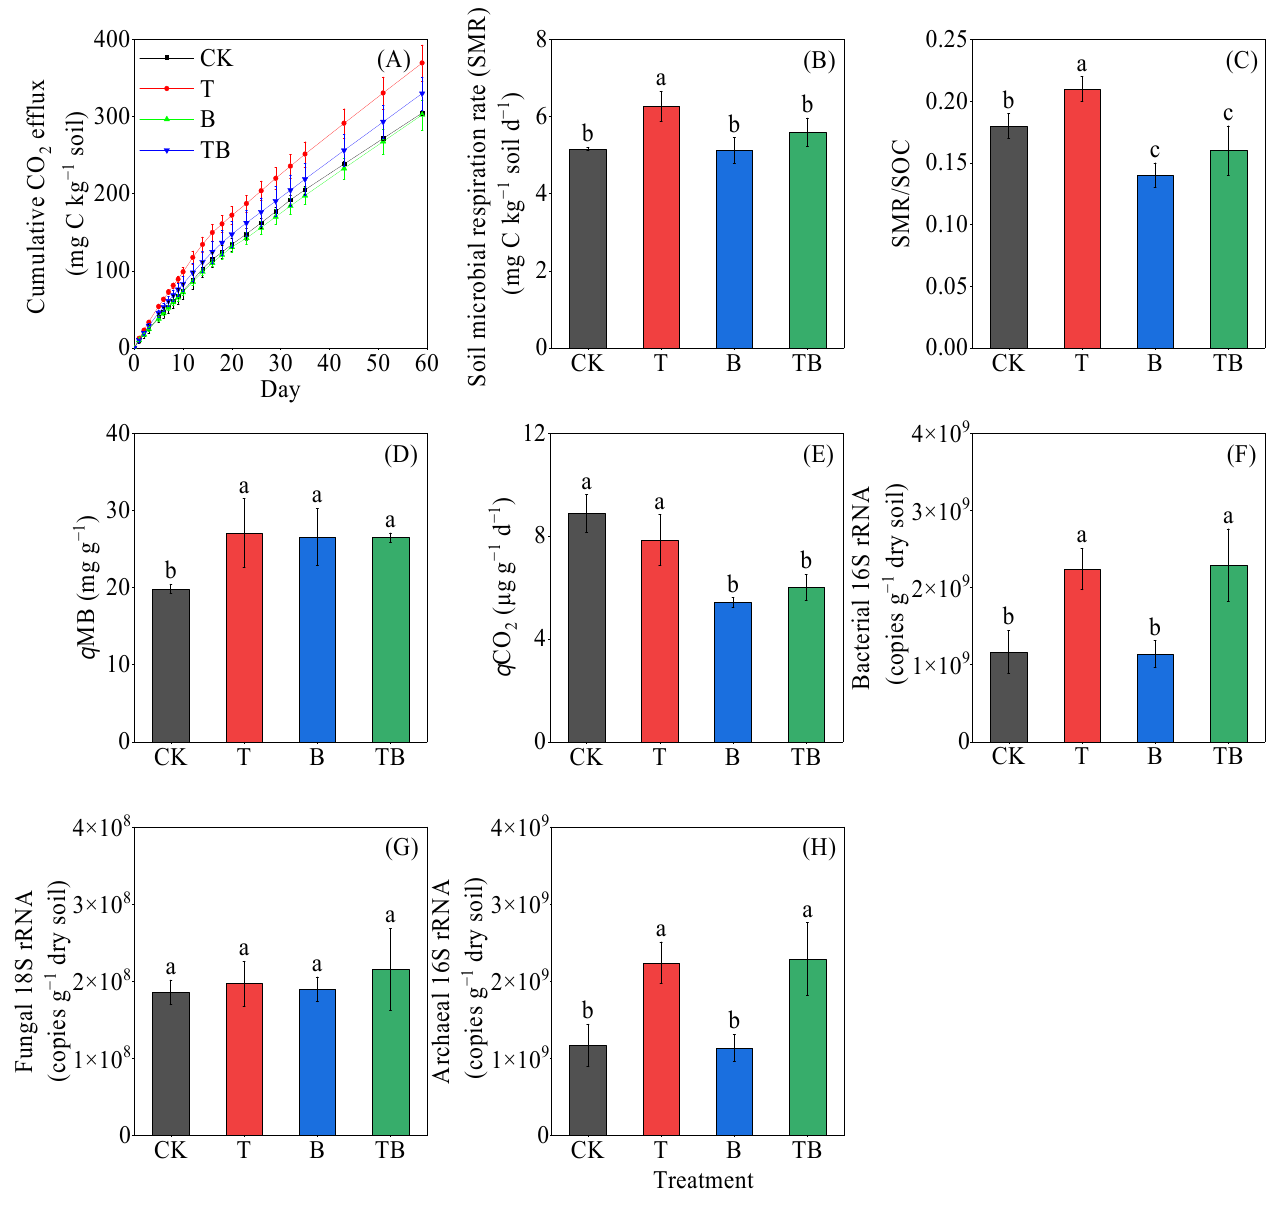
Figure 2. A comparison of cumulative CO 2 efflux ( A ), soil microbial respiration rate (SMR) ( B ), the ratio of SMR/SOC ( C ), soil microbial quotient ( q MB) ( D ), soil microbial metabolic quotient ( q CO 2 ) ( E ), and the gene abundances of bacteria, fungi and archaea ( F – H ) (mean ± SE) among the different treatments including the control (CK), oyster shell powder (T), biochar (B) and a combined amendment (TB). Bars with different letters indicate significant differences ( p < 0.05). Compared with CK, T treatment significantly ( p < 0.05) increased MBC, MBN, soil microbial quotient ( q MB), and the ratio of SMR/SOC by 37.4%, 45.4%, 36.5%, and 16.7%, respectively, but had no effect on the q CO 2 (Figure 1D,E and Figure 2C–E). B significantly increased MBC and q MB by 61.9% and 33.8% while decreasing q CO 2 and SMR/SOC by 39.0% and 22.2%, respectively (Figures 1D and 2C–E). Compared with T, TB signifi- cantly ( p < 0.05) increased MBC while decreasing q CO 2 and SMR/SOC by 23.5% and 23.8% (Figures 1D and